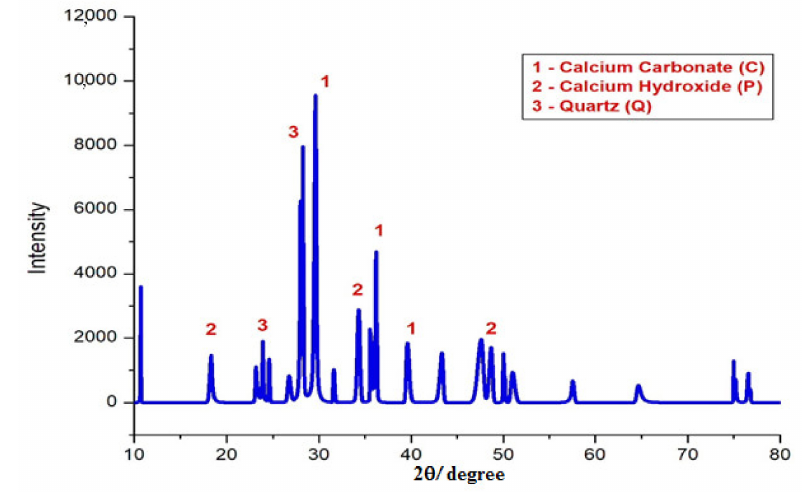
Figure 16. XRD pattern of lime mortar.